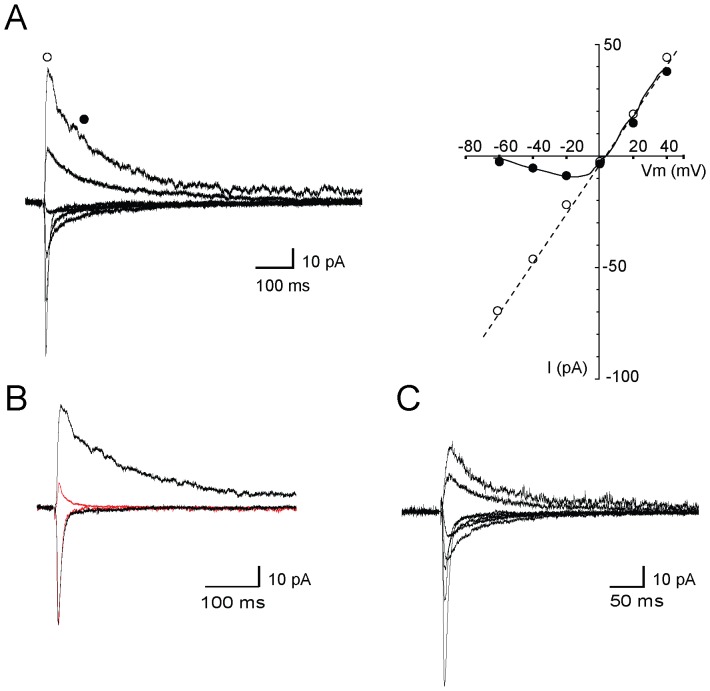
Dual Component Glutamatergic Synapses Onto Immature Granule Cells.A. Synaptic currents recorded in a EGFP-expressing dentate gyrus granule cell held at various membrane potentials between −60 mV and +40 mV, in response to medial perforant path stimulation. The current-voltage relationship (right) is plotted for currents measured at the peak (open circle) and 100 ms later (closed circles). Newborn dentate gyrus granule cells have dual component synapses that exhibit a linear component (AMPA+NMDA) and a component that is blocked at negative potentials (NMDA). B. Current traces at −60 mV and +40 mV before (black) and after (red) block of NMDA channels by d-AP5. C. Dual component synapse recorded from a mature dentate gyrus granule cell.